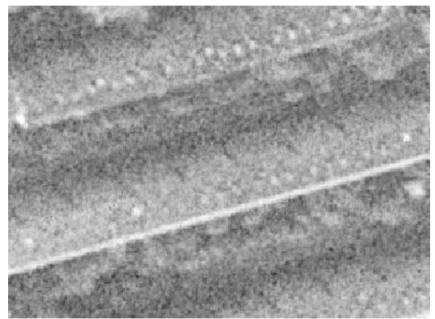
Figure 6. Poor radiometric quality of the 1993 image.